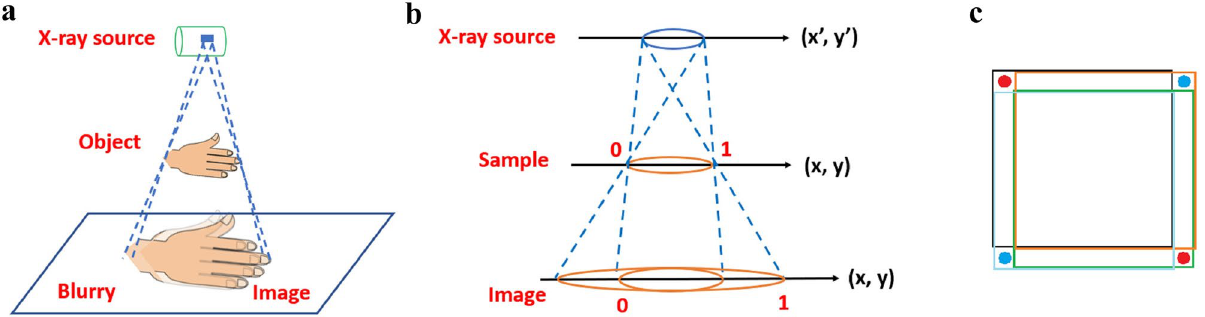
Figure 1. ( a ) Due to the ballistic nature of short wavelength x-rays, and submicron coherent lengths, a non- point source produces many projected beams through an object, all of which are then superimposed onto each other, to form a blurred image on the detector screen. ( b ) From the projection geometry, the image p(x,y) is simply given by the sample f(x,y) convoluted over the light source distribution g(x’,y’), where the scale of (x,y) for f, and p, can be adjusted to simplify the derivation. ( c ) The “square aperture difference” of p(x,y), convoluted by a point f with a square g, where the green square = p(x,y), orange = p(x,y + d), black = p(x + d,y + d), blue = p(x + d,y). To be consistent with the data matrix, the upper left corner is taken as the origin of (x, y), and d the amount of shift along the x,y axes. The resulting 4 p’s cancel each other everywhere, except for the positive red dots, sized by d, and negative blue dots, which will be dropped when re-written into an